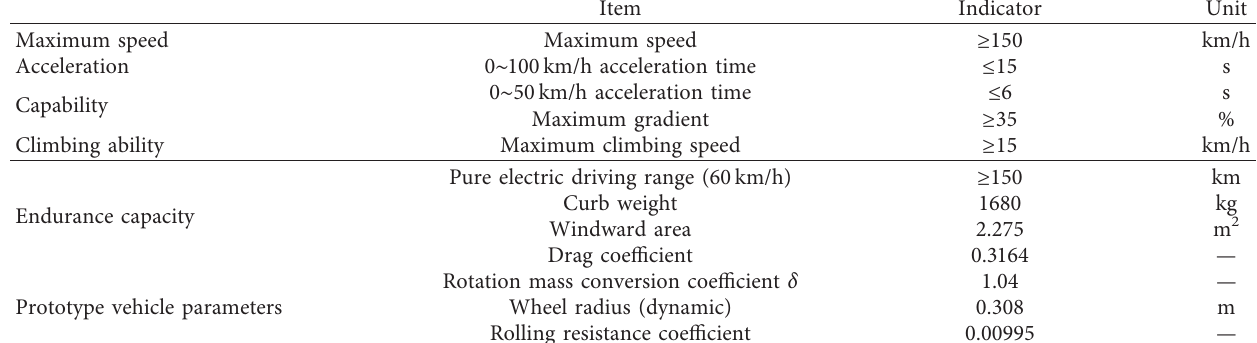
Table 1: The performance indicators and parameter of pure electric vehicle.